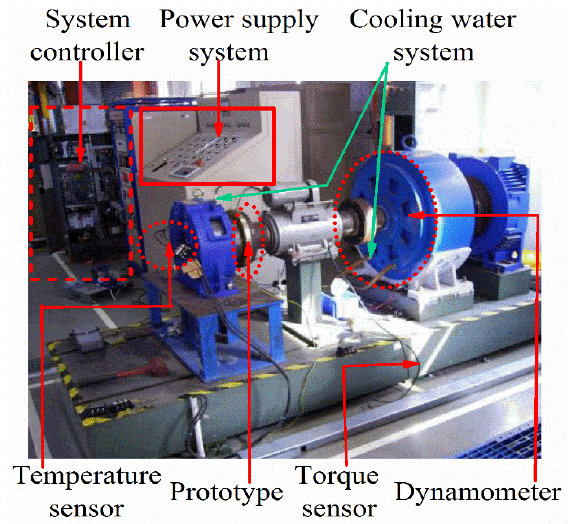
Figure 7. Prototype experimental platform.